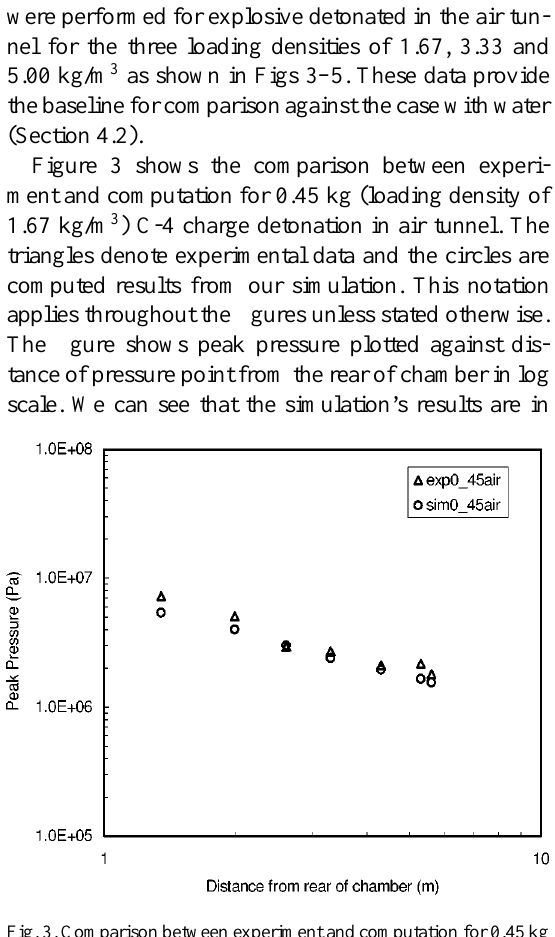
Fig. 3. Comparison between experiment and computation for 0.45 kg C4 charge detonation in